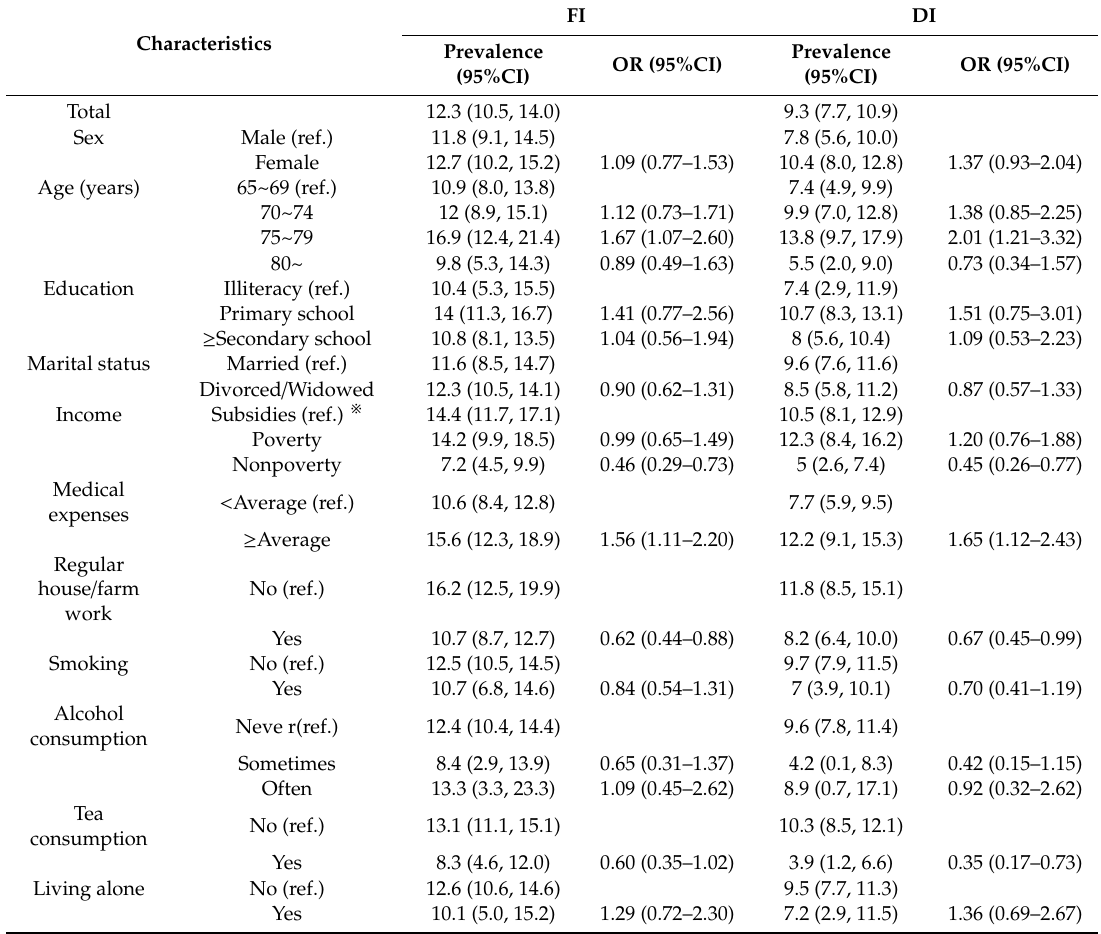
Table 3. Prevalence of FI and DI and univariate